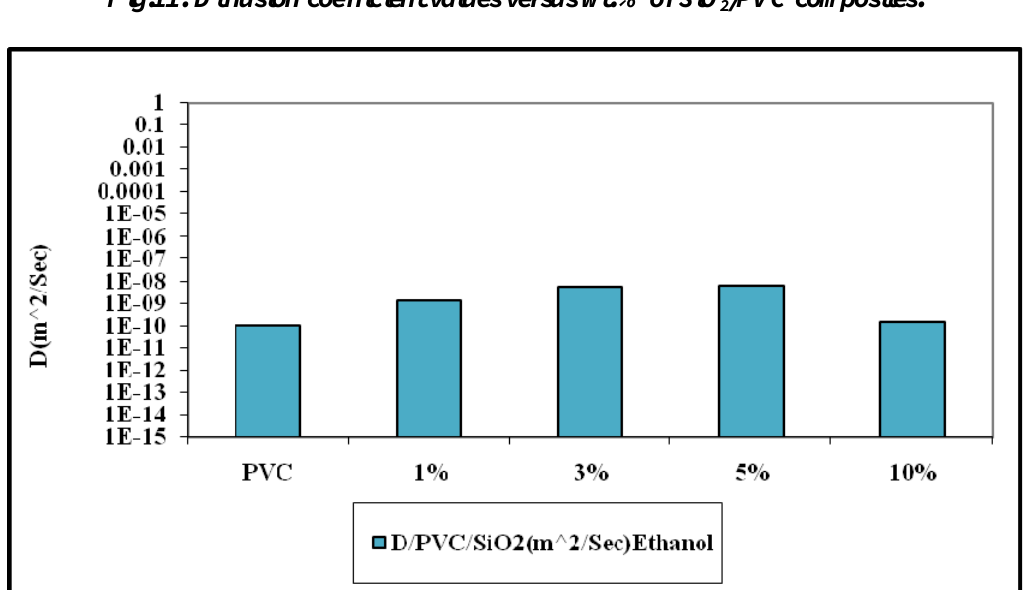
Fig.11: Diffusion coefficient values versus wt. % of SiO